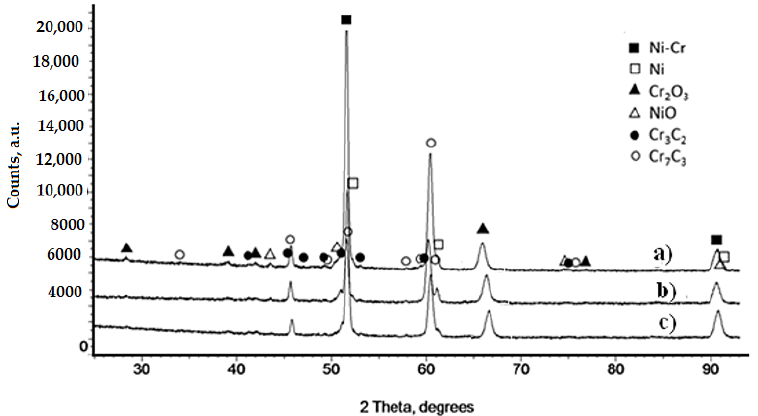
Figure 5. X-ray diffraction patterns obtained for the Cr 3 C 2 -25(Ni20Cr) cermet coatings on the Al7075 substrate after laser remelting for the spot speed: ( a ) 600 mm/min, ( b ) 800 mm/min, and ( c ) 1000 mm/min.